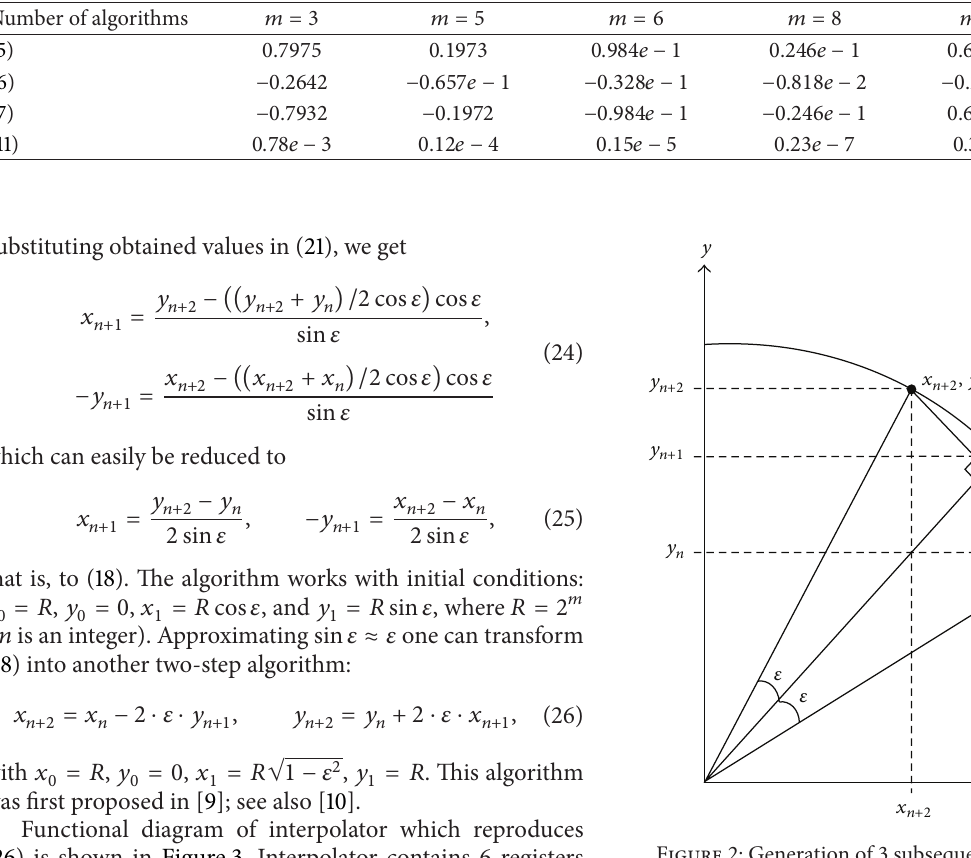
Figure 2: Generation of 3 subsequent points along the circle.